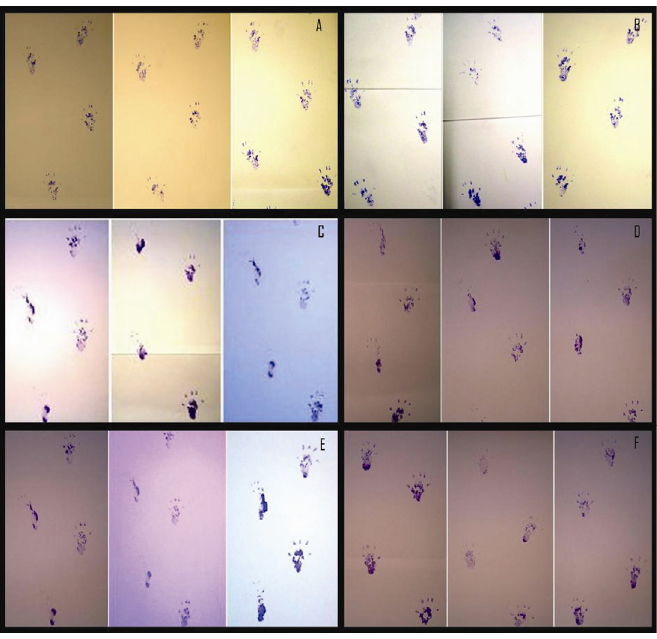
FIGURE 4 - Comparison among the prints of groups A, B and C in the first and the second walking track tests: detailed appearance of the prints of three animals on the 30th and the 90th days. Prints of a group A animal, on the 30th ( A ) and the 90th days ( B ), showing their symmetry. Prints of a Group B animal, showing atrophy of the LPL on the 30th ( C ) and 90th days ( D ). Prints of a Group C animal, showing atrophy of the LPL on the 30th ( E ) day and functional recovery on the 90th day ( F ) FIGURE 5 - Fibular nerve histological photomicrography of Groups A, B and C. The red arrows represent examples of mielinic axons. (Dying: Hematoxylin-Eosin; 400 time TABLE 2 – Number and diameter of myelinated axons average values per field on the 90th day of the study